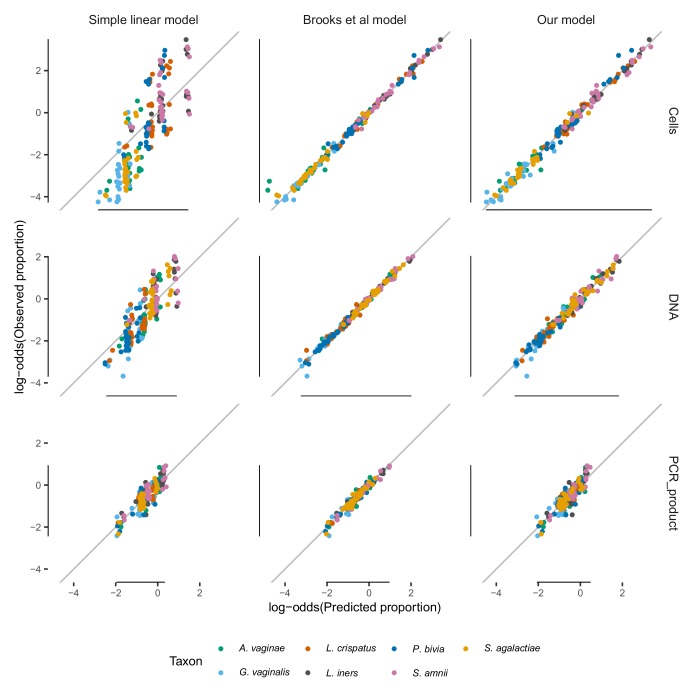
Comparison between the simple linear model, the linear interactions model of Brooks et al. (2015), and our model.Comparison of the model fits for the simple linear model, the linear interactions model of Brooks et al. (2015), and our model. The simple linear model has a poor fit, while the Brooks et al. (2015) model closely fits the data but does so by having more parameters per taxon (63 per taxon) than distinct sample compositions (58). Our model fits nearly as well as the Brooks et al. (2015) model for the Cells and DNA mixtures, while having vastly fewer parameters (6 versus 441 for all taxa). Proportions p are transformed to log-odds (ln⁡[p/(1-p)]) to avoid compressing errors near p=0 and p=1. The simple linear model with and without an intercept term gives nearly identical results except near zero; here shown without. Only taxa with non-zero actual abundance are plotted, and proportions predicted to be greater than one by the simple linear model are not shown.